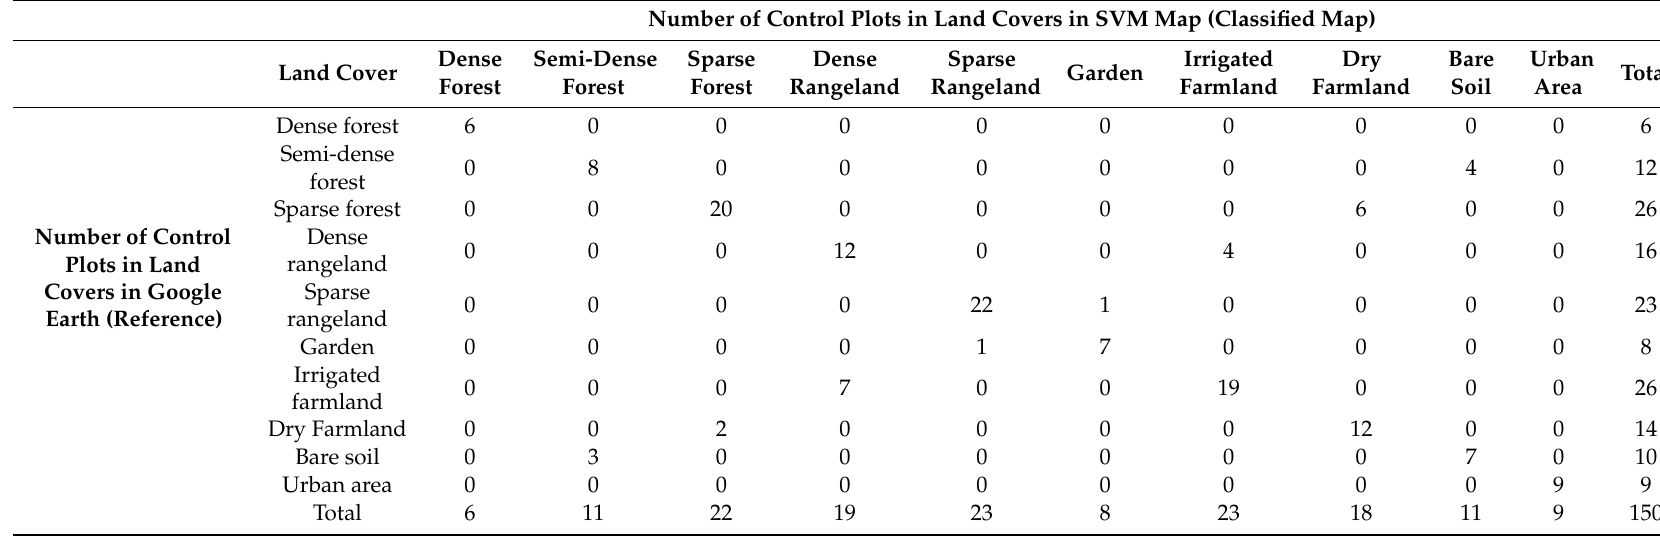
Table 5. The confusion matrix of comparison of control plots in support vector machine (SVM)-land cover map (classified) and Google Earth